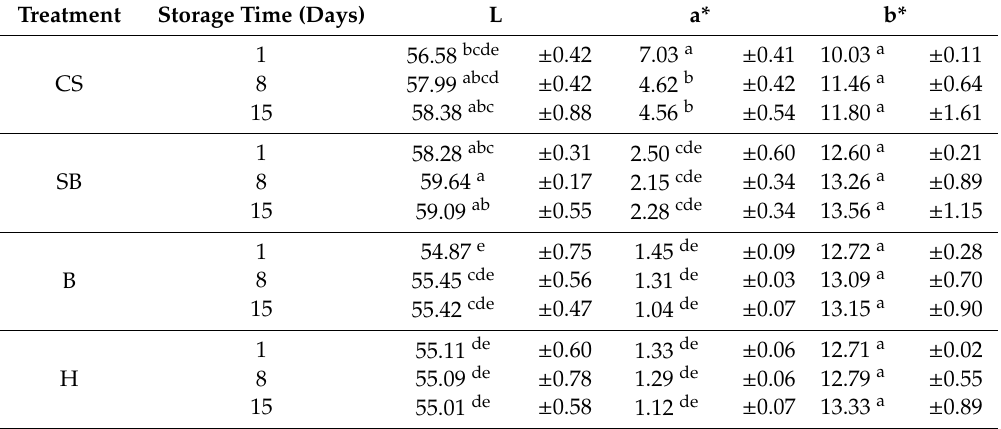
Table 4. Colour changes during storage (mean values ± standard errors (SE).